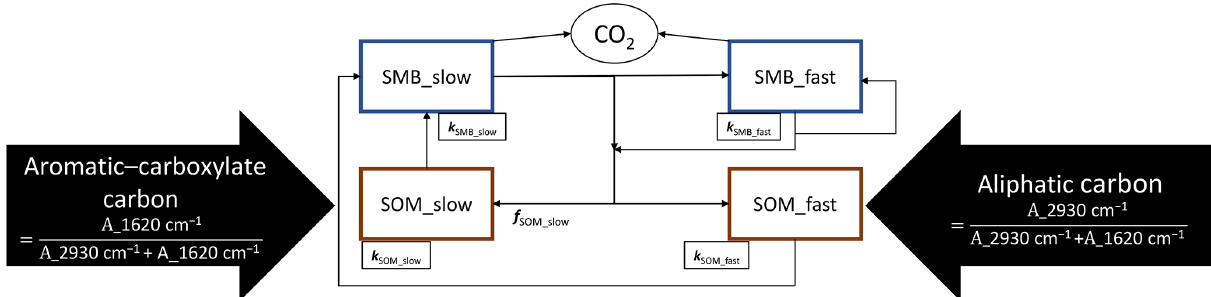
Figure 7. Suggested improvements to the internal cycling structure of SOM in the Daisy model. The division into fast- and slow-cycling SOM, corresponding to aliphatic and aromatic–carboxylate carbon follows the turnover or death of either SMB pool. Aliphatic carbon no longer becomes aromatic–carboxylate carbon without the involvement of